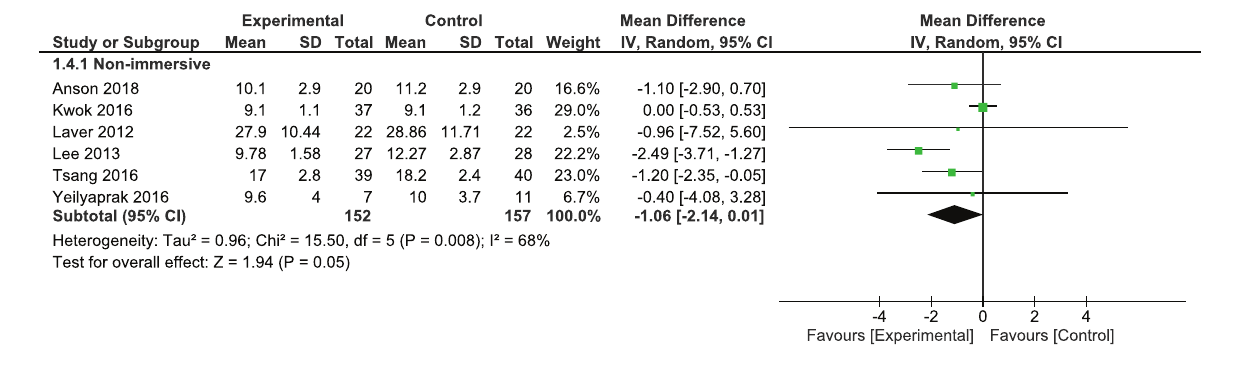
FIGURE 2 | Forest plot of outcome measures for balance assessment using timed tasks, specifically timed up-and-go (TUG), for VR-based therapy vs. control (EoT).